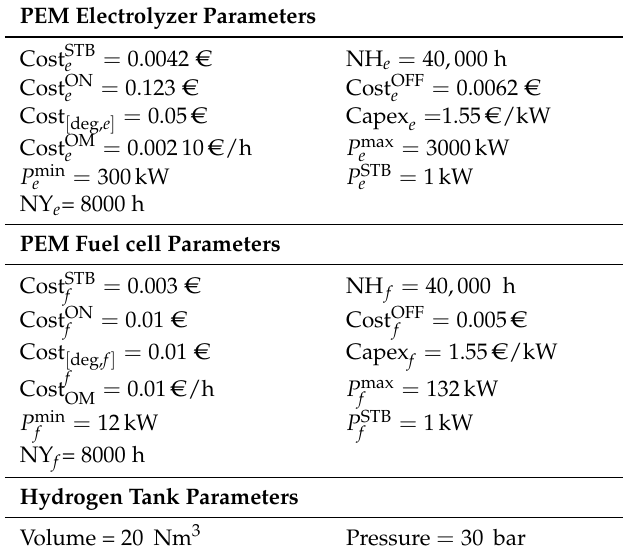
Table 4. Cost Factor values utilized by the MPC, data based on the literature